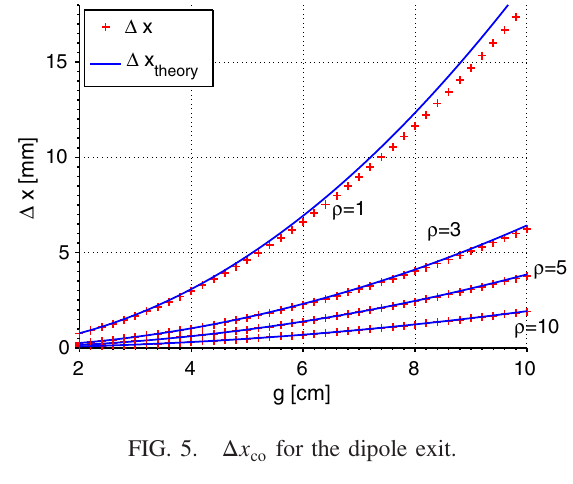
FIG. 7. Octupolelike potential effect on ∂ 3